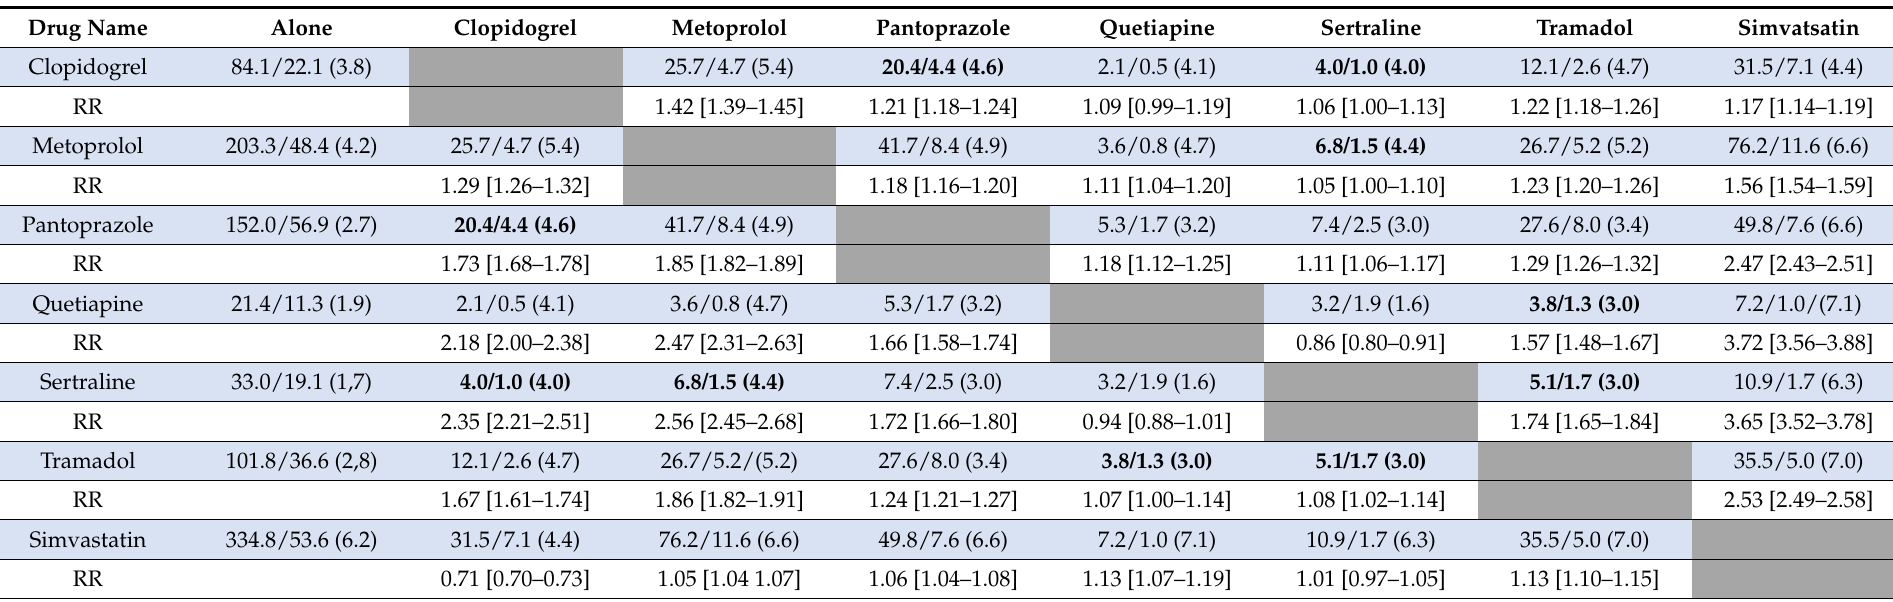
Table 5. Prevalences of use and relative risks